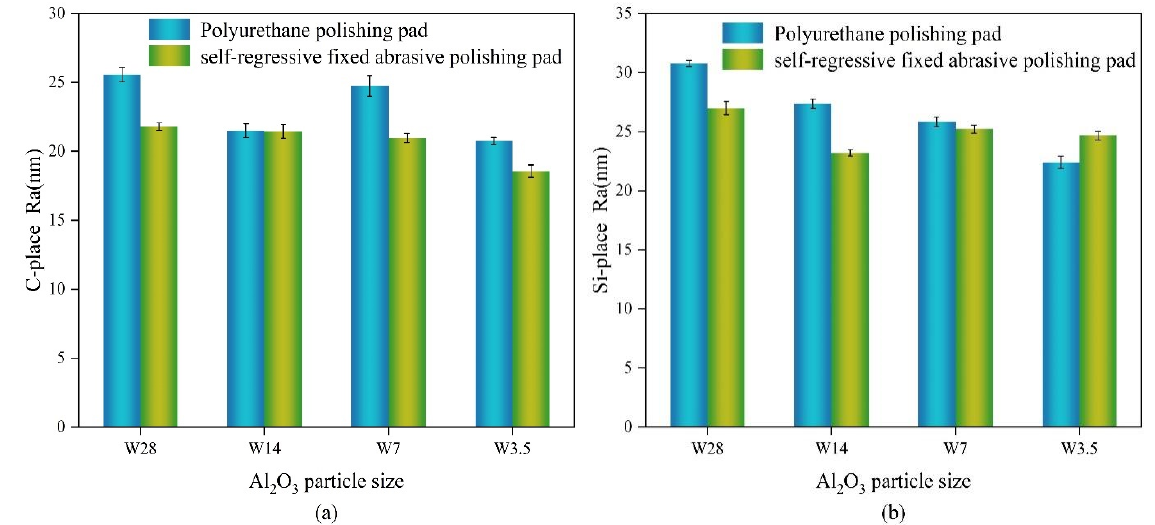
Figure 17. The polishing effect of the abrasive particles’ size on both sides of the C and Si planes. ( a ) Surface roughness of the C surface. ( b ) Surface roughness of the Si surface.